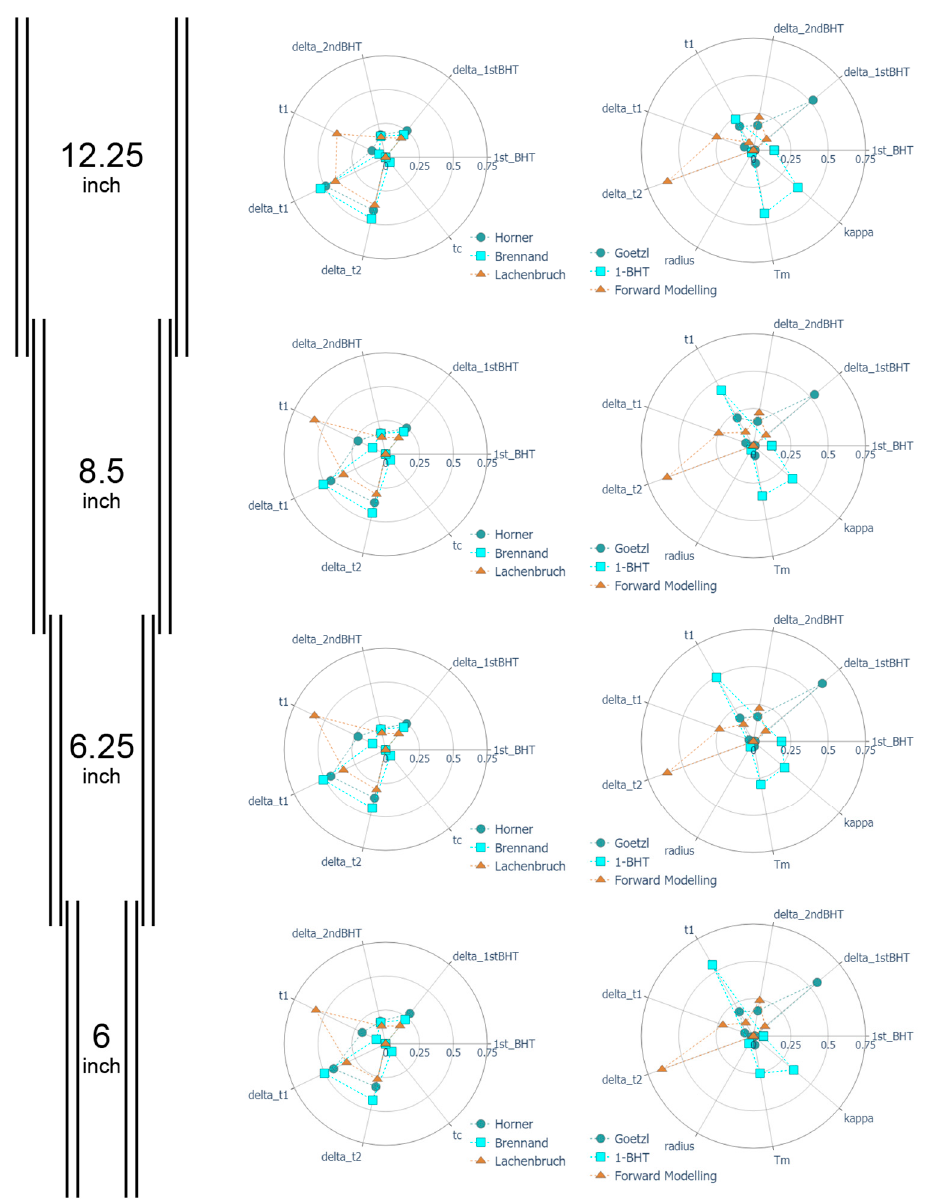
Figure 9. Results of the GSA structured by borehole sections. Shown are Sobol total indices for each relevant input parameter. The margin of the total order index corresponds to the importance of the respective parameter to the model output. The diagrams on the left show the methods that are solved graphically, those on the right show the analytical methods. The abbreviations refer to the first measured BHT and respective shut-in time (1st_BHT, t1), the increase in temperature from first to second BHT and the respective shut-in time gone by (delta_1stBHT, delta_t1), the increase in temperature from second to third BHT and the respective shut-in time gone by (delta_2ndBHT, delta_t2), the circulation time ( t c ), the mud temperature ( T m ), and the bulk thermal diffusivity of the system mud/borehole